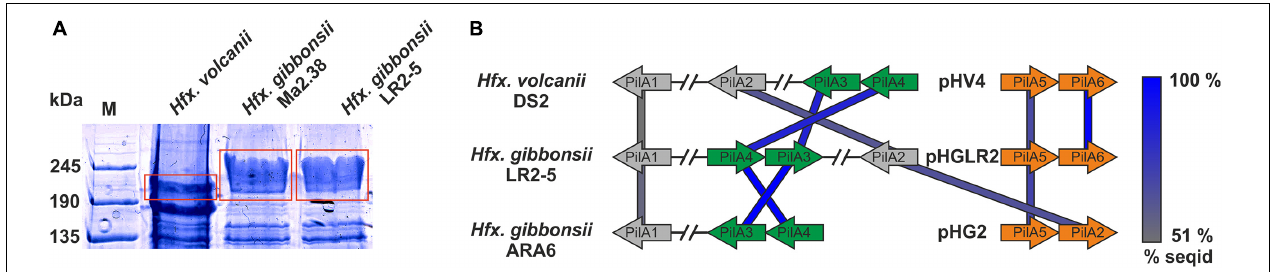
FIGURE 4 | Surface protein and pili of Hfx. gibbonsii LR2-5. (A) Coomassie stained SDS-PAGE gel of Hfx. volcanii , Hfx. gibbonsii Ma2.38, and Hfx. gibbonsii LR2-5 whole cell lysates. The prominent bands at around 245 kDa are considered to run at the height of the S-layer glycoproteins (red boxes). The LR2-5 band was subjected to mass spectrometry. (B) Comparison of the genetic loci of Hfx. gibbonsii LR2-5 PilAs with those of Hfx. gibbonsii ARA6 and Hfx. volcanii DS2 T . Homologs to all six Hfx. volcanii pilins are present in Hfx. gibbonsii LR2-5; however, particularly PilA1, PilA2, and PilA5 are more distant homologs (protein sequence identity 51–68%). PilA3 and PilA4 are organized in an operon in all three strains and the proteins have high protein sequence identity ( ≥